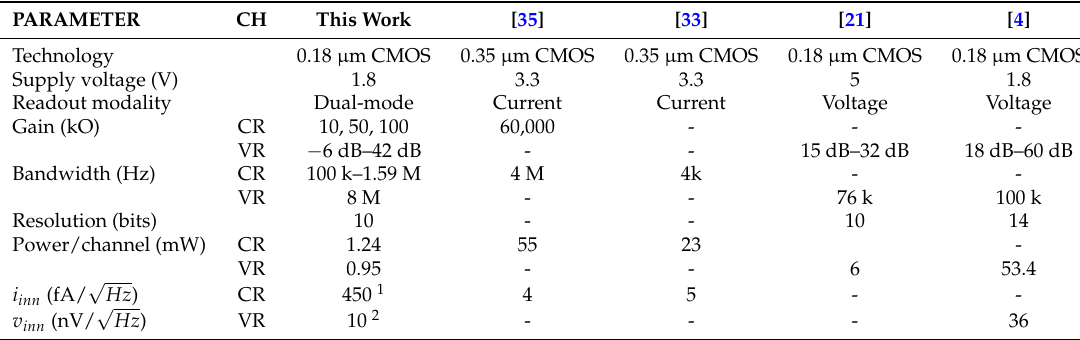
Table 2. Performance comparison of the analogue front-end for